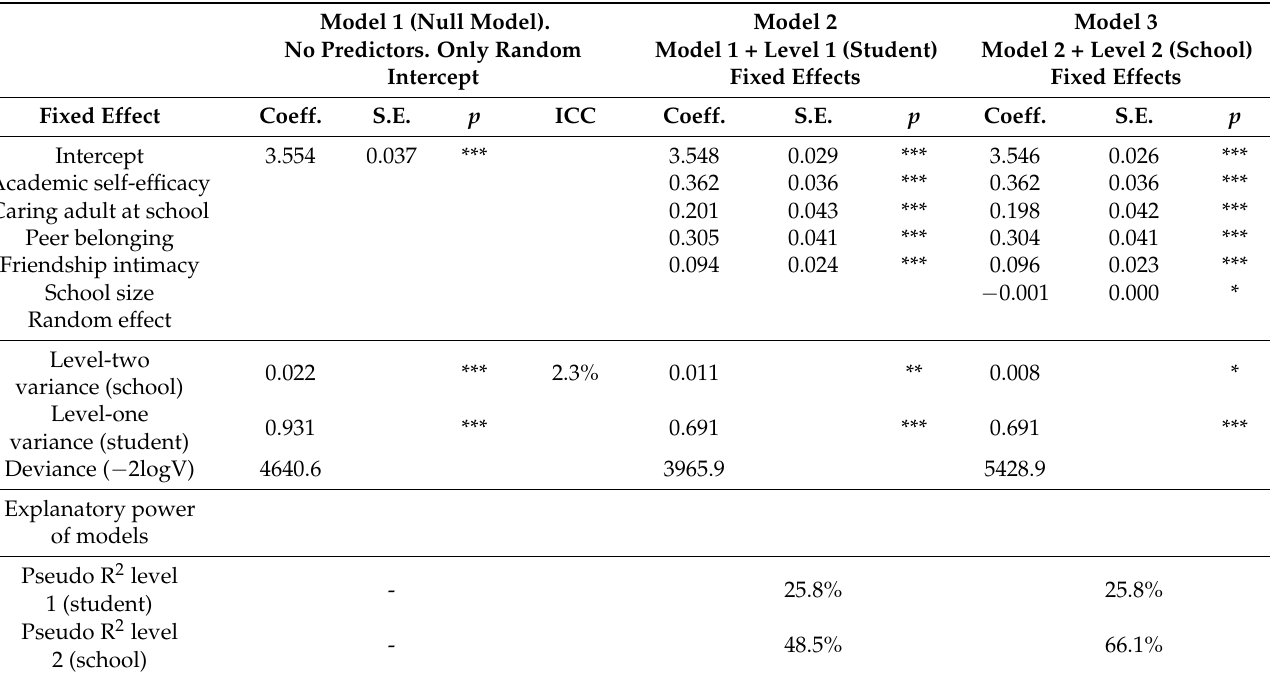
Table 1. Hierarchical linear modeling results of students and school effects on sense of school belonging.